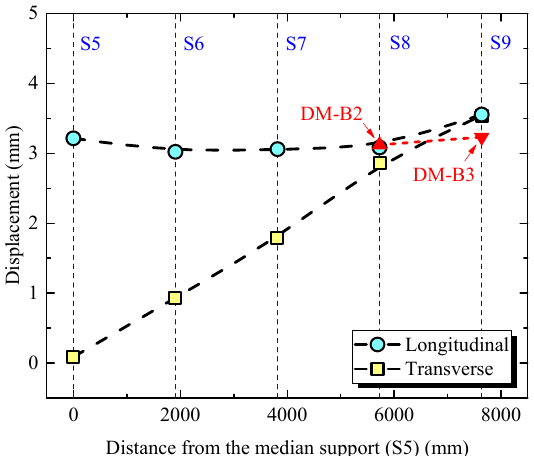
Figure 11. Comparison of monitored and numerical results of displacement of bearings.